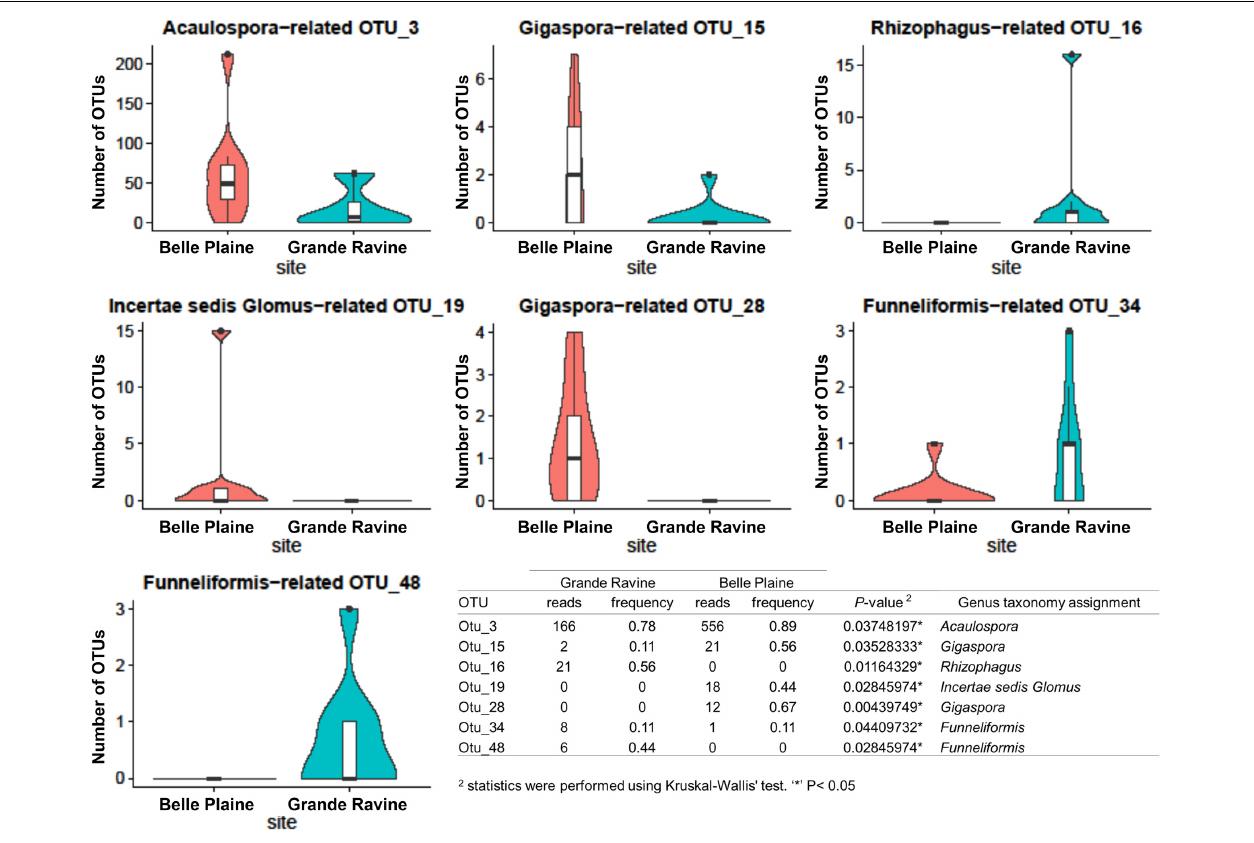
FIGURE 1 | Abundance of arbuscular mycorrhizal (AM) fungal operational taxonomic units (OTUs) between Grande Ravine and Belle Plaine forest sites. Only OTUs with significant ( P < 0.05) differences in their relative abundance between the both forest sites are shown. Table represented comparison of AM fungal OTU abundances between localities (Belle Plaine and Grande Ravine) with statistics were performed using Kruskal–Wallis’ test. ∗ P < 0.05.